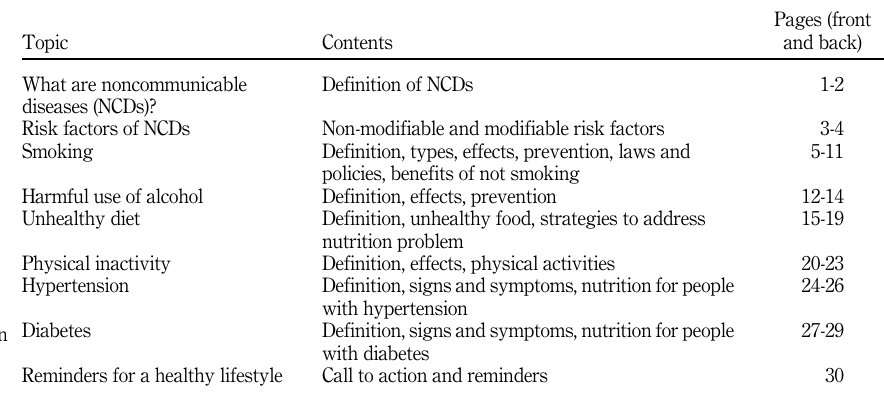
Table 1. General information on the contents of the